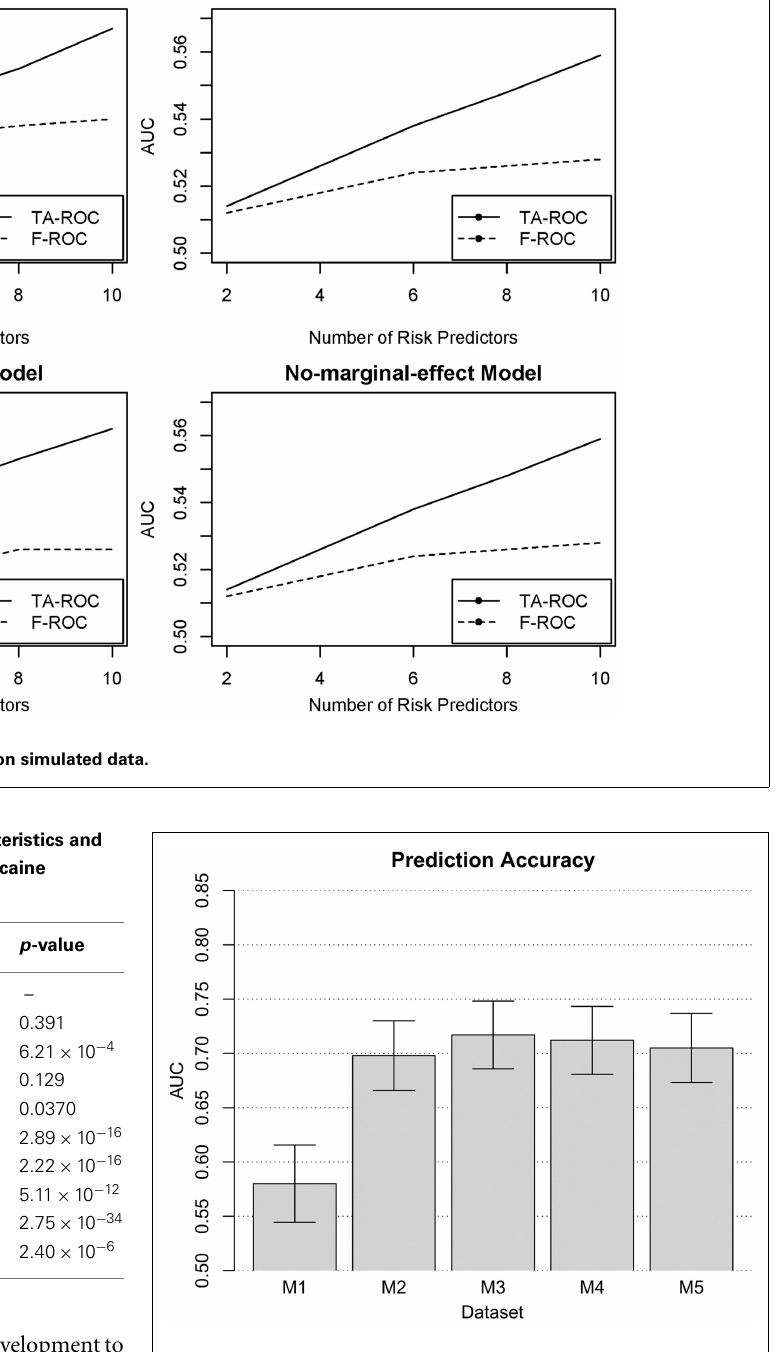
FIGURE 3 |The performance of the risk-prediction model at each p -value threshold. Risk-prediction models M1, M2, M3, M4, and M5, comprised of 3, 38, 330, 2761, and 25460 SNPs with a p -value threshold of 10 − 6 , 10 − 5 , 10 − 4 , 10 − 3 , and 10 − 2 ,